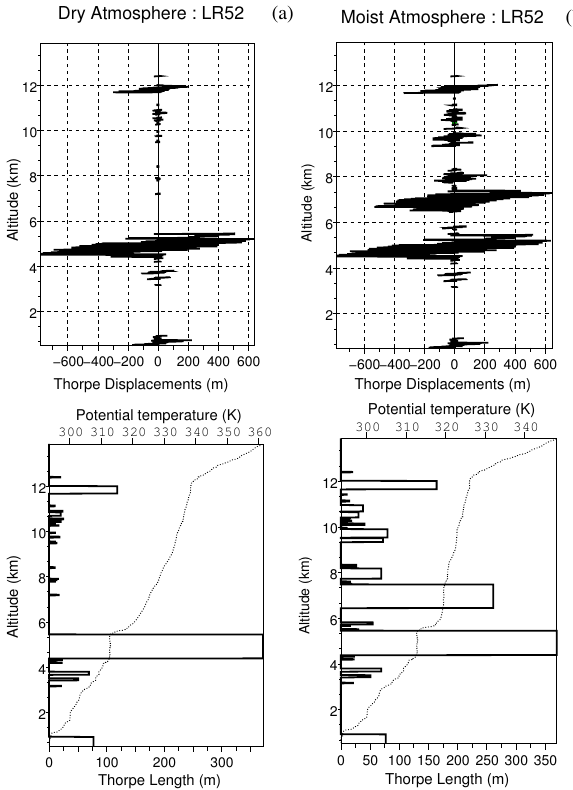
Fig. 2. (a) Thorpe displacements for the detected overturning events in flight 52 (top panel) and the corresponding Thorpe lengths (bot- tom panel) for a dry atmosphere. The bottom panel also shows the θ profile (dotted line). (b) Same as (a) , but by including moisture ef- fects and by applying the Zhang et al. (2010) criterion. The bottom panel also shows the θ ∗ profile (dotted line).